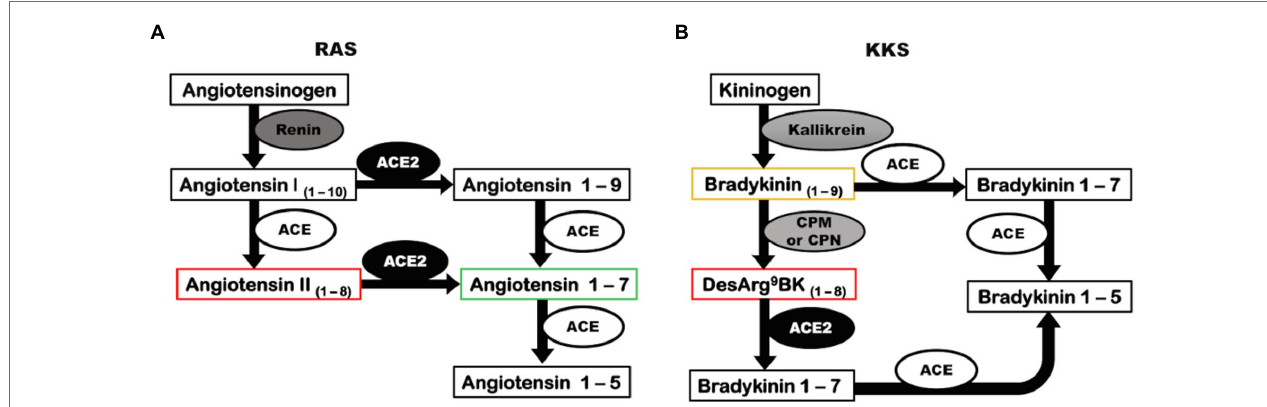
FIGURE 1 | Angiotensin-converting enzyme 2 has a catalytic role in RAS and KKS. (A) Renin converts the precursor, angiotensinogen, into angiotensin I. In a classic pathway, angiotensin I is cleaved by ACE to form Angiotensin II. ACE2 can biosynthesize angiotensin 1–7 by two distinct pathways: acting directly on angiotensin II or alternatively converting angiotensin I into angiotensin 1–9 that is further cleaved by ACE, generating angiotensin 1–7. (B) The precursor kininogen is cleaved by kallikrein to form the active peptide, bradykinin that is rapidly degraded by ACE, or in an alternative pathway, can be converted to desArg 9 bradykinin by CPM and CPN. ACE2 can inactivate desArg 9 bradykinin. ACE, angiotensin-converting enzyme; ACE2, angiotensin-converting enzyme 2; CPM, carboxypeptidase M; CPN, carboxypeptidase N; KKS, kallikrein-kinin system; and RAS, renin-angiotensin